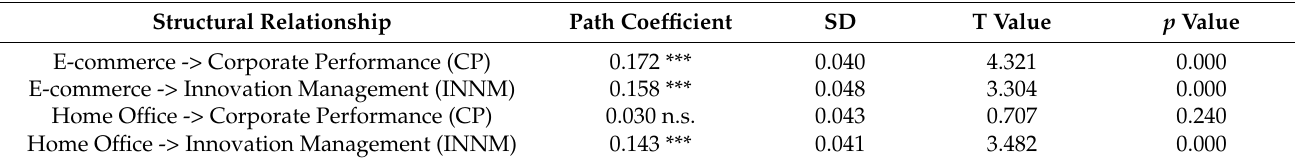
Table 5. Results of the effect of the control